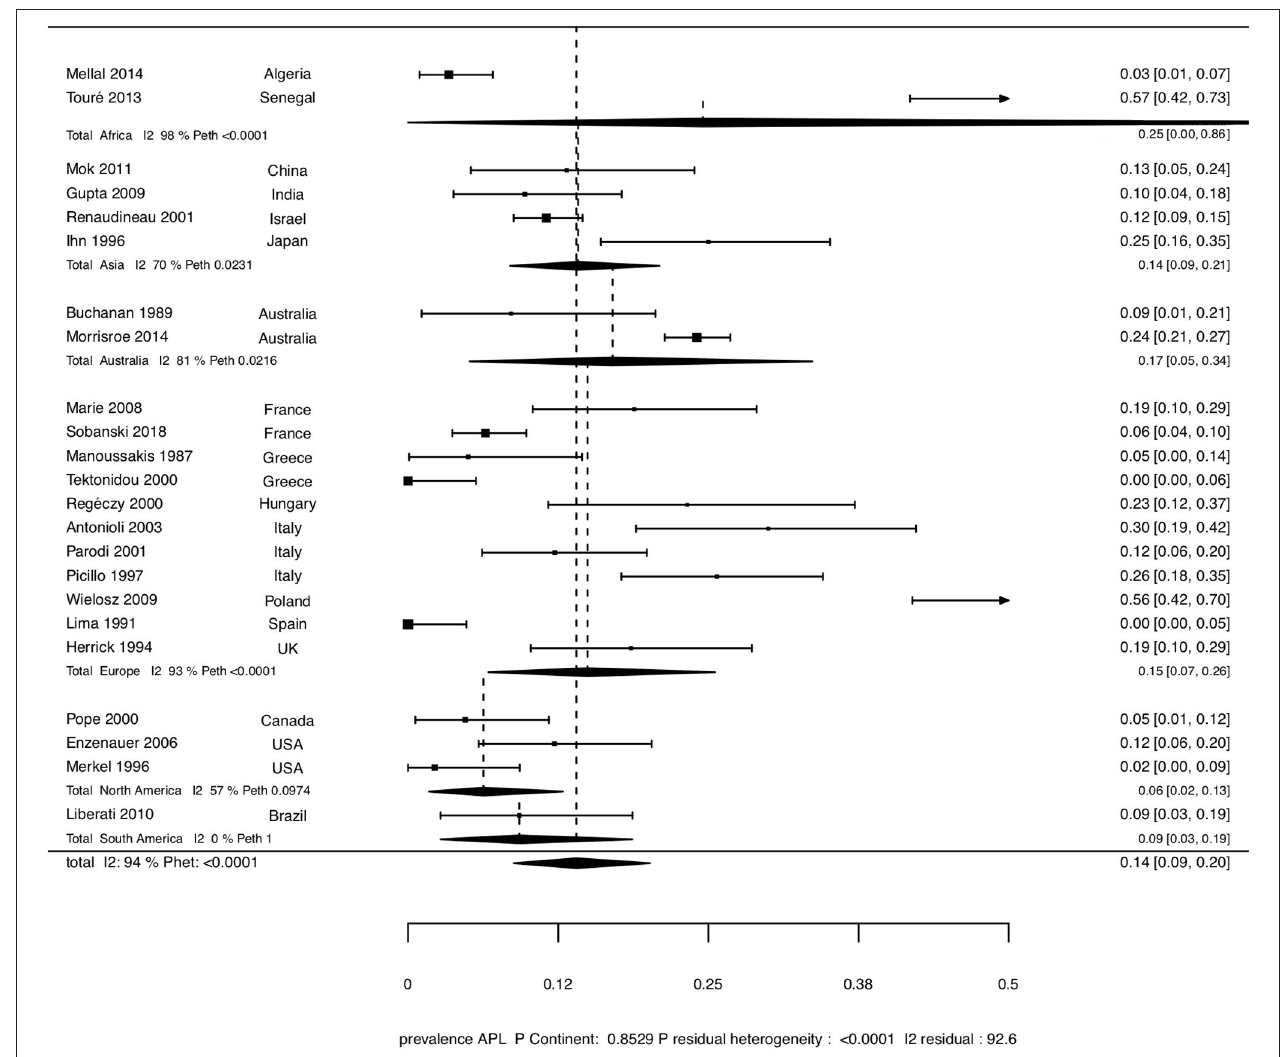
FIGURE 3 | Forest plot showing the pooled prevalence of aPL in the whole population of SSc patients, and stratified by continent.